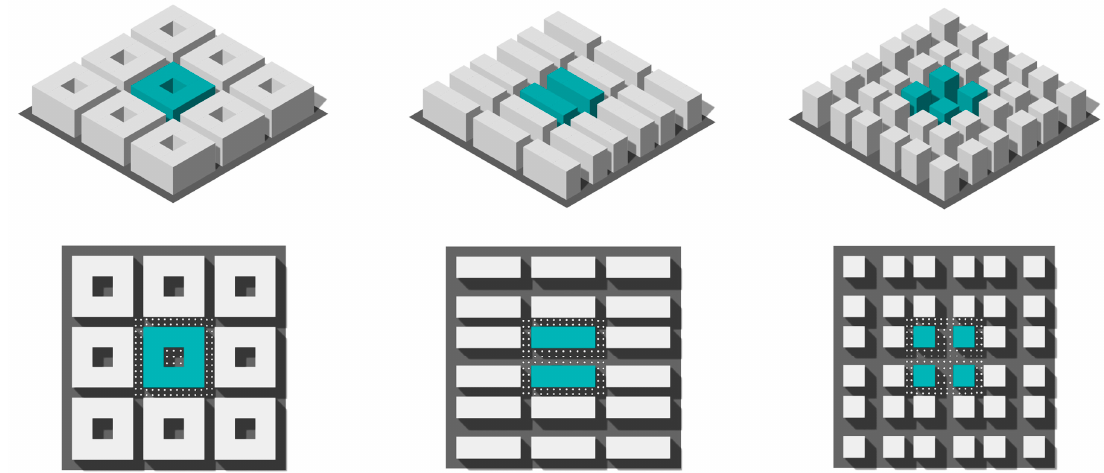
Figure 1. Three archetypes exemplified in this study as a 3D View (top) and Top view showing the points of interest in outdoor comfort studies (Bottom). Table 1. Minimum, maximum and step size of each dynamic parameter simulated.